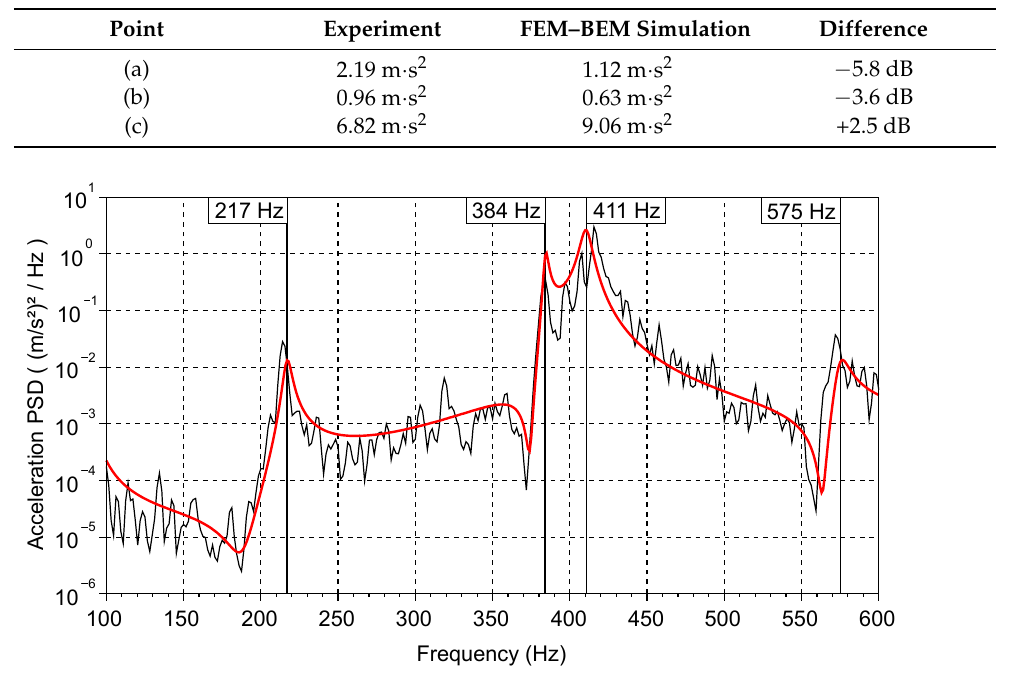
Table 1. Test–simulation comparison of the overall RMS level (in the [100–2200 Hz] range) for the three locations studied.